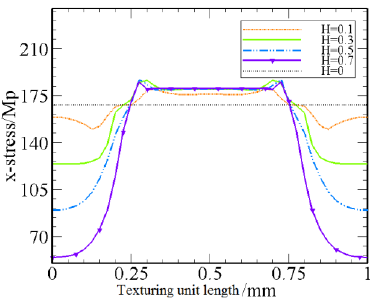
Figure 11. Distribution of stresses along the x –direction at different texturing depths and W = 0.5.